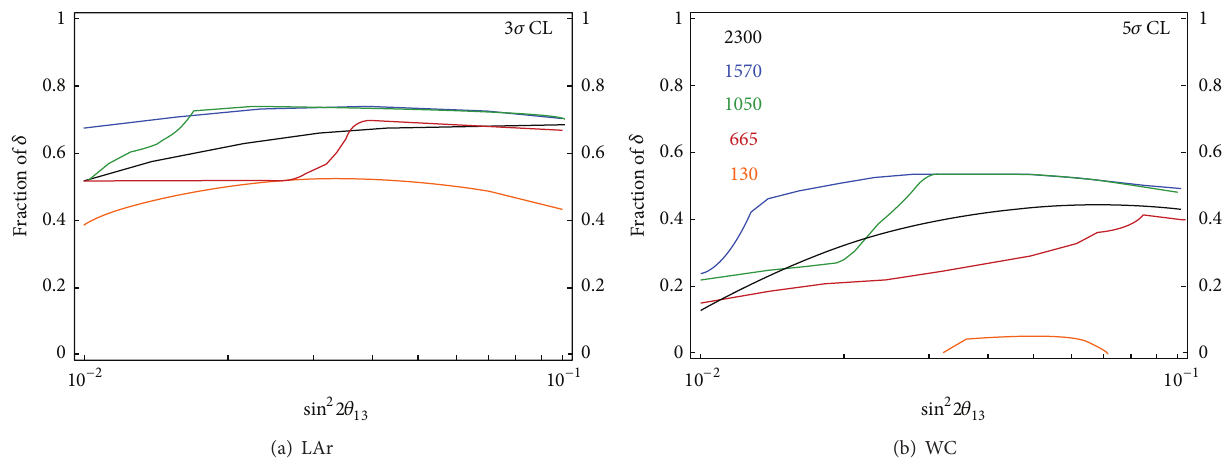
Figure 13: LAGUNA CP fraction for which a CP violation discovery at 3𝜎 (left) and 5𝜎 (right) is possible as a function of sin 2 2𝜃 13 for the LAr (upper plots) and WC (lower plots) detector. Figure is taken from [107].